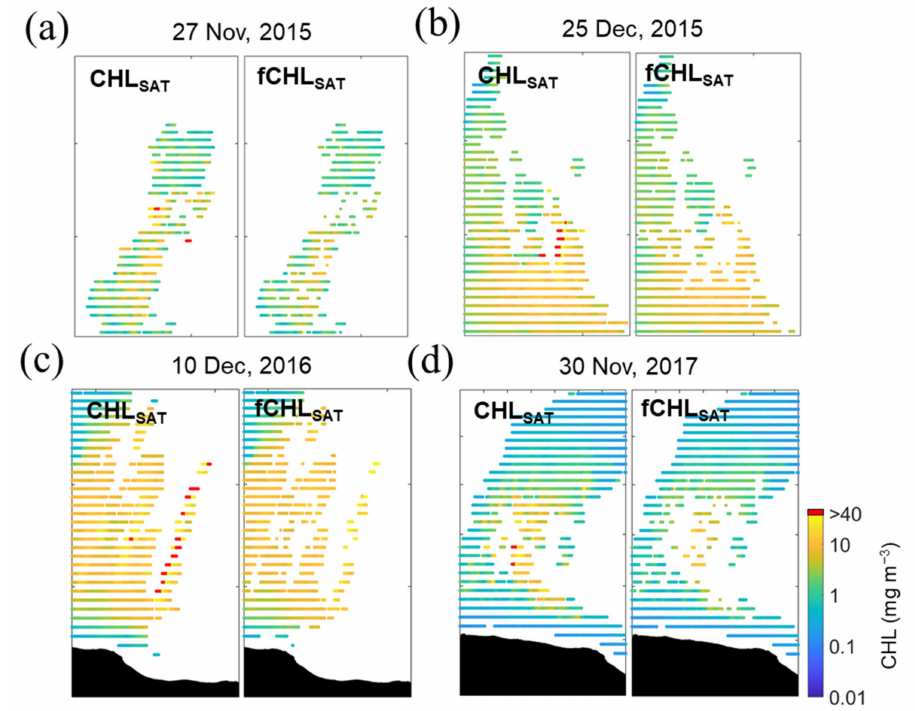
Figure 4. Close-up views of the CHL maps around regions containing large CHL values ( > 40 m m − 3 ). Left panels show the CHL SAT maps and the right panels are the maps of the CHL filtered (fCHL SAT ) by the normalized median test, which is set to b = 5 and θ = 1.1, in ( a ) 27 November 2015, ( b ) 25 December 2015, ( c ) 10 December 2016 and ( d ) 30 November